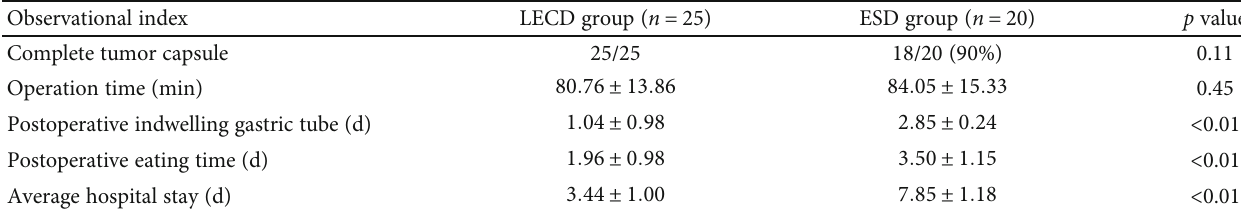
Table 2: Comparison of perioperative data between LECD group and ESD group.